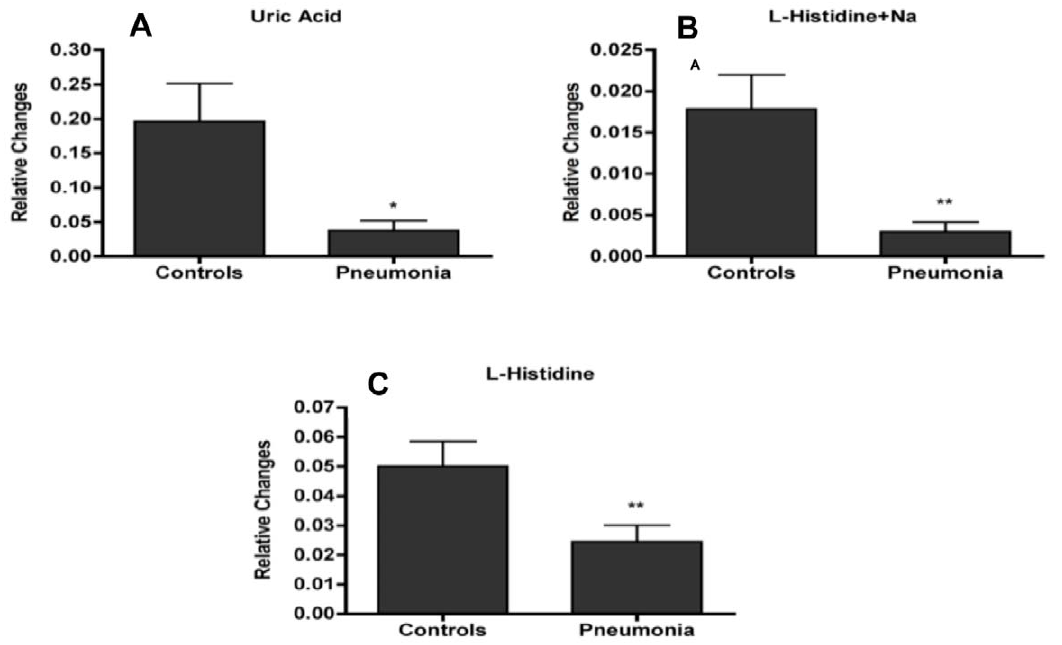
Figure 3. Relative changes of urinary ions that were verified with tandem mass spectrometry. Data is represented at the mean 6 SE of the peak areas extracted through the TOFMS data (with * representing p , 0.05 and ** representing p , 0.01). The real peak areas were normalized to each sample’s respective creatinine ([M + H] + =114.0667 m/z ) peak area. doi:10.1371/journal.pone.0012655.g003 PLoS ONE |